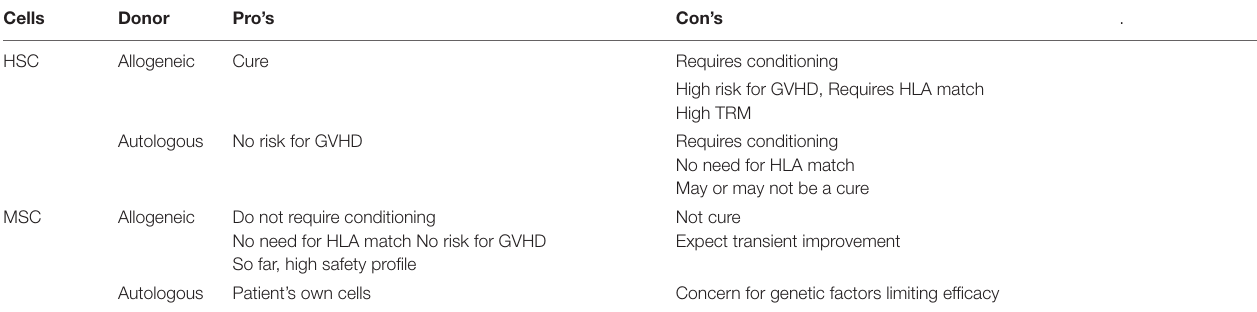
TABLE 1 | Cell based treatment of autoimmune